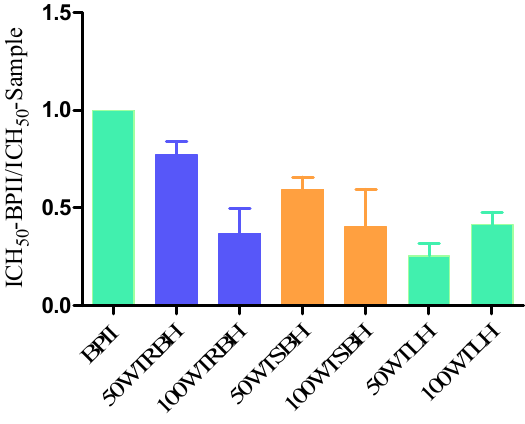
Figure 1. Complement-fixating activities of the crude water extracts obtained by ASE from root bark, stem bark and leaves of T. macroptera related to positive control (BP II